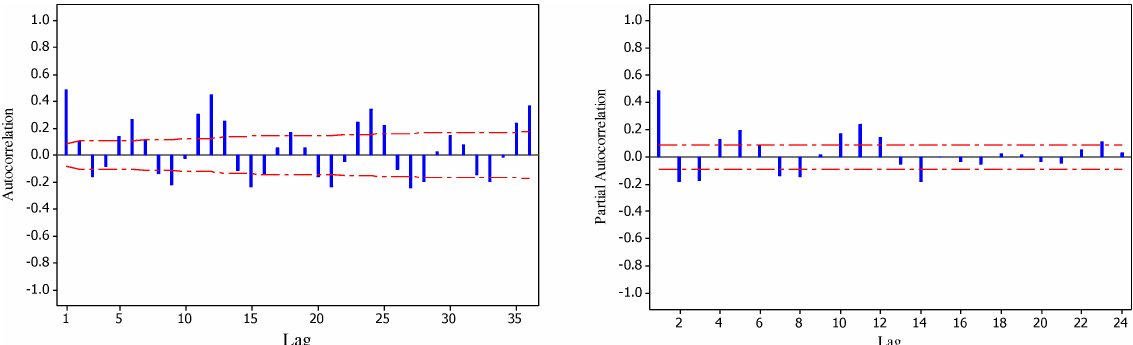
Fig. 8. The autocorrelation and partial autocorrelation of river flow series of Bernam